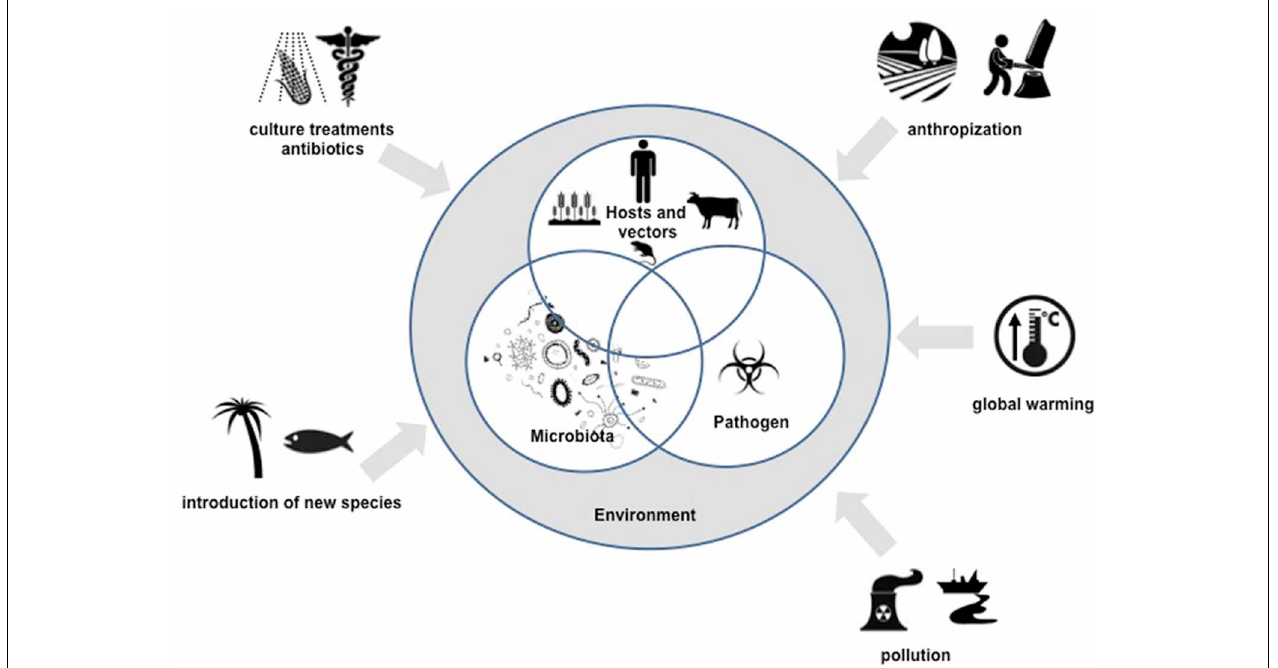
FIGURE 1 | Overview of the pathobiome concept and scientific challenges for the coming years.